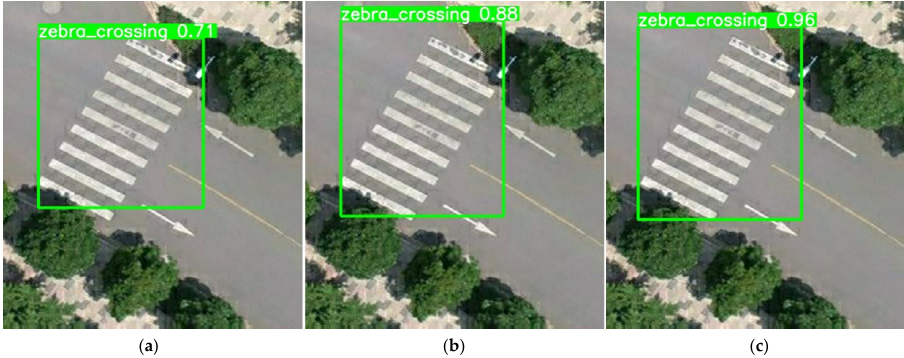
Figure 8. Detection effects under different K-means: ( a ) YOLOv5; ( b )YOLOv5 + K-means; and ( c ) YOLOv5 + K-means++.